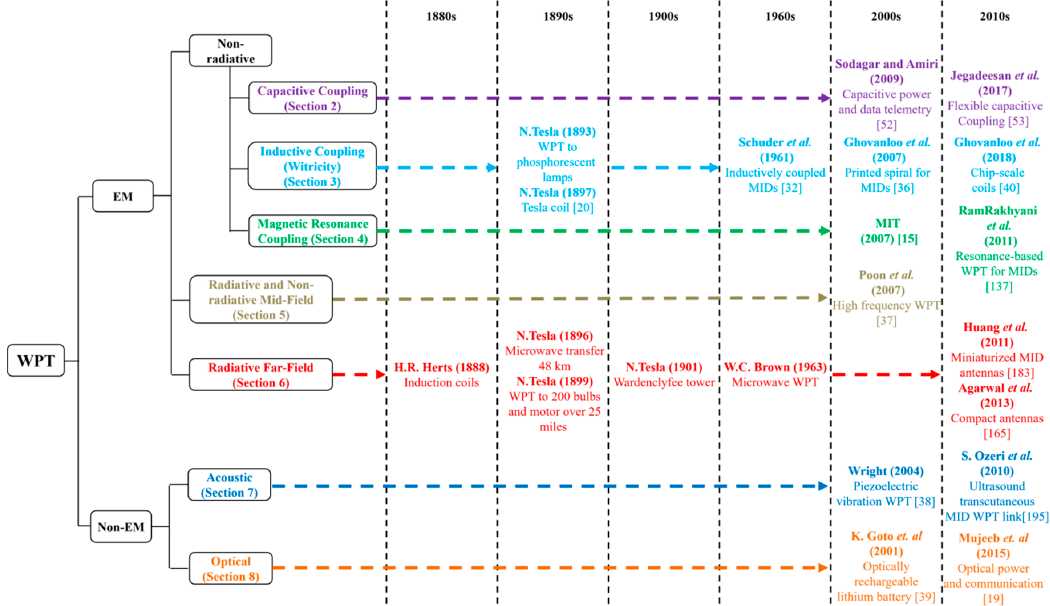
Figure 1. Classification and research overview of wireless power transfer (WPT) techniques indicating the key milestones relevant to implantable medical devices (IMDs).